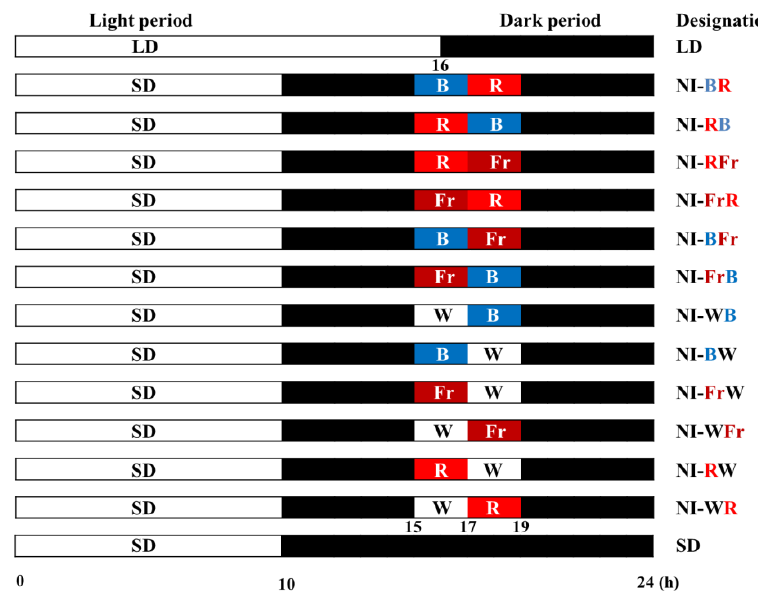
Figure 1. Light quality shifting with light-emitting diodes (LEDs) during the 4 h night interruption (NI) in the 10 h short-day (SD) treatments: NI-BR, blue to red; NI-RB, red to blue; NI-RFr, red to far-red; NI-FrR, far-red to red; NI-BFr, blue to far-red; NI-FrB, far-red to blue; NI-WB, white to blue; NI-BW, blue to white; NI-FrW, far-red to white; NI-WFr, white to far-red; NI-RW, red to white; and NI-WR, white to red. LD indicates the 16 h long-day treatment.